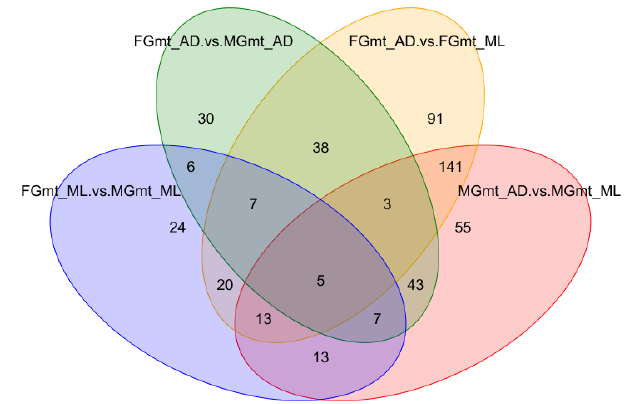
Figure 3. Venn diagram of the differential metabolites. The diagram illustrates the unique and common differential metabolites in the FG_AD vs. FG_ML, MG_AD vs. MG_ML, MG_AD vs. FG_AD and MG_ML vs. FG_ML groups, based on a statistical significance cut-off of p -adj < 0.05.